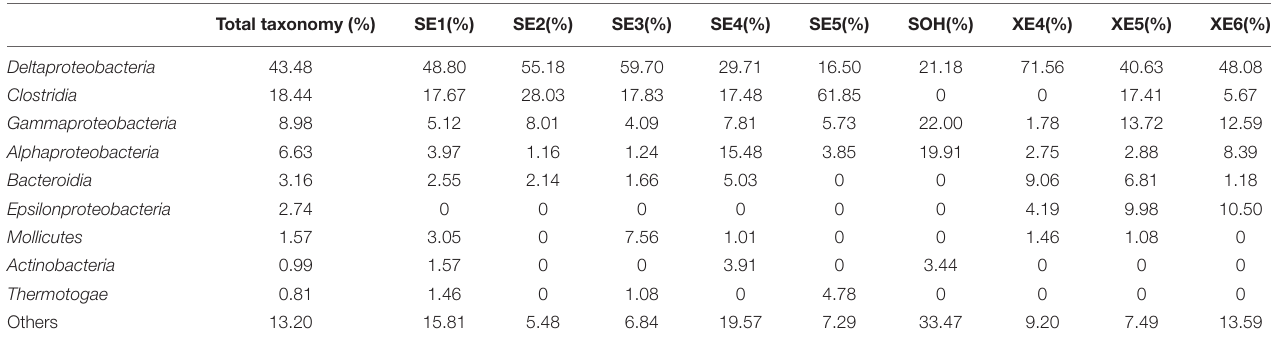
TABLE 3 | Microbial community compositions at class